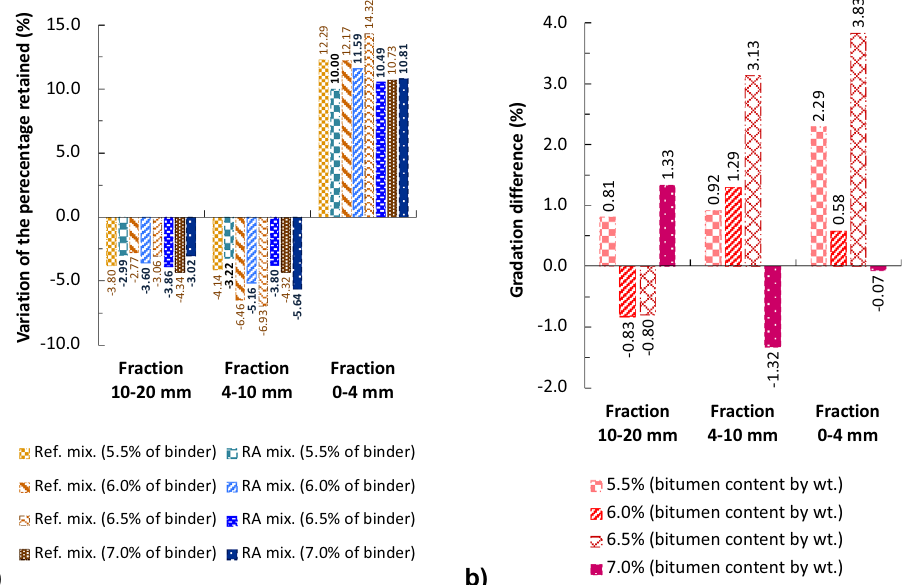
Figure 6. Aggregate gradation change of cylindrical specimens after compaction: ( a ) Variation of the percentage retained for each aggregate fraction (negative values indicate reduction of the fraction); ( b ) gradation difference between RA mixtures and Ref. mixtures (positive values indicate lower gradation change by employing the rubberized